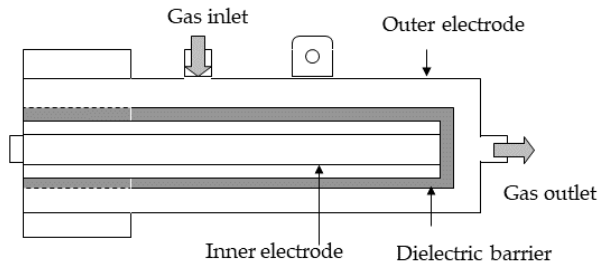
Figure 1. Diagram of the ozone tube used in this study.